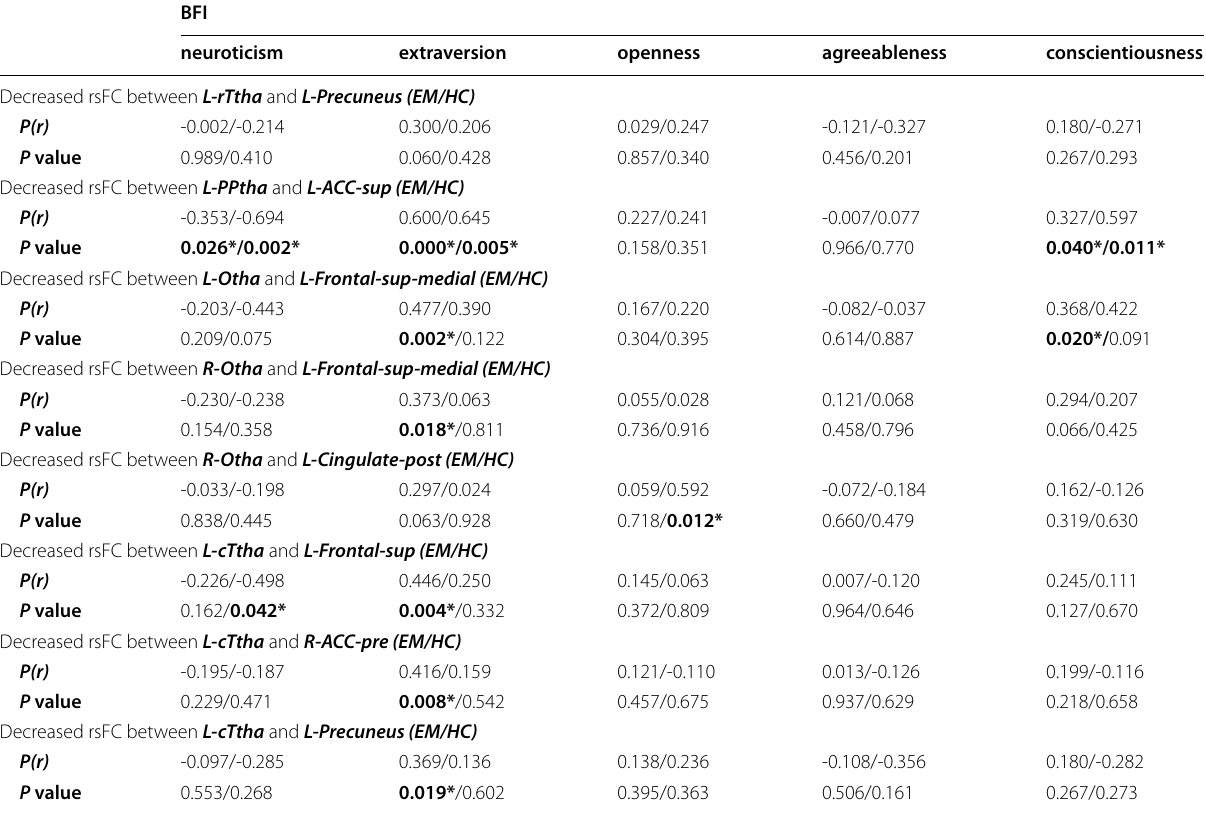
Table 6 Partial correlations between decreased rsFC and BFI in patients with episodic migraine and HCs after controlling for age, sex, education, and